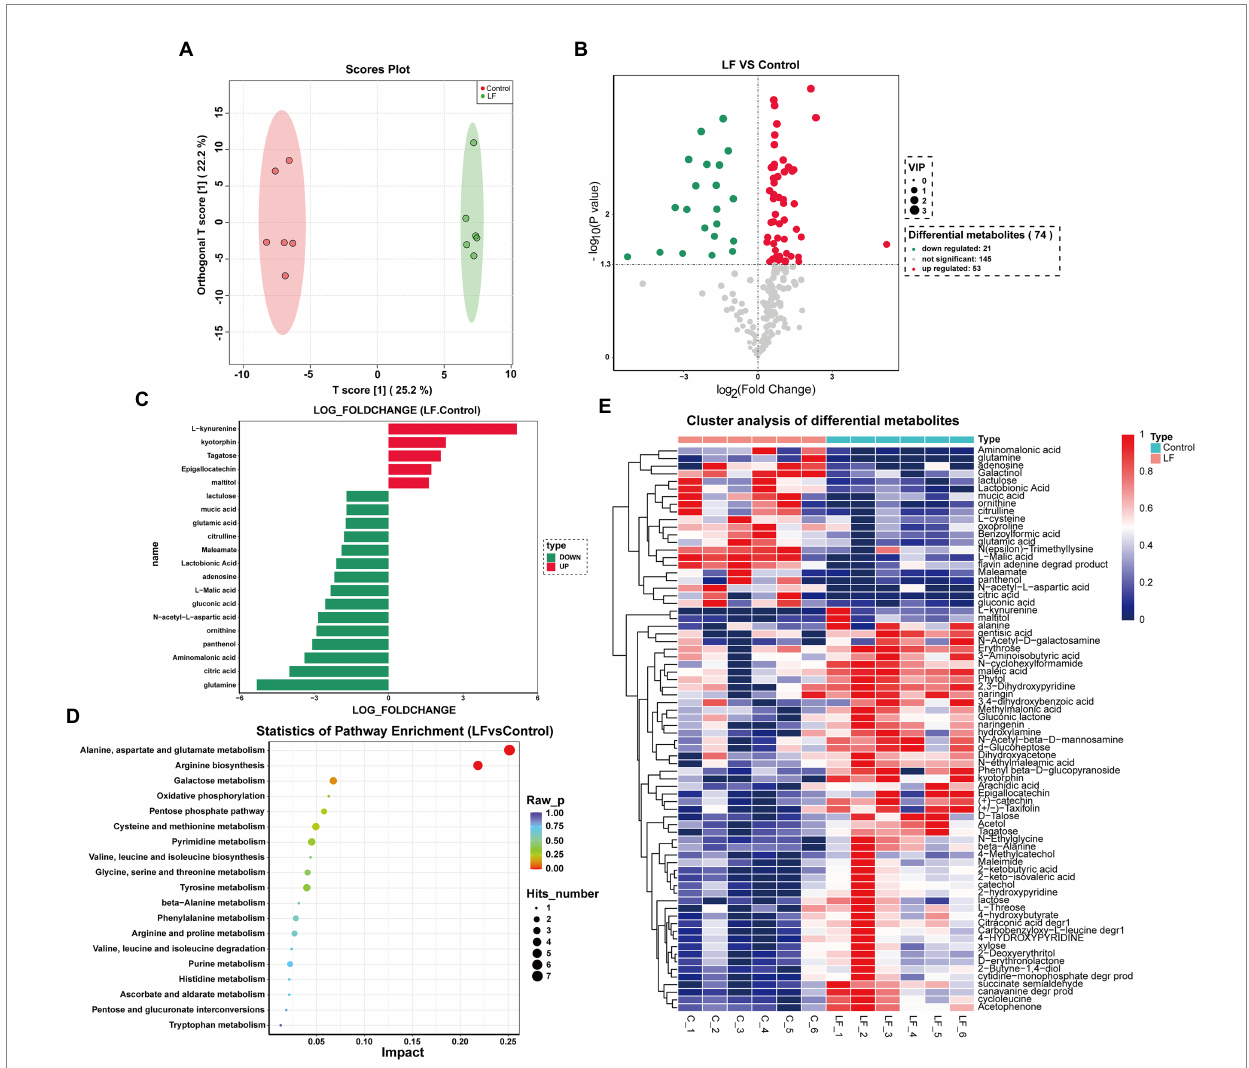
FIGURE 3 Cluster analysis of differential metabolites and KEGG enrichment analysis. (A) OPLS-DA diagram of comparison combination; (B) volcanic map of differential metabolites screening between combinations; (C) column diagram of differential metabolites between combinations; (D) KEGG metabolic pathway analysis of each comparison combination; (E) hierarchical cluster analysis heat map of each comparison